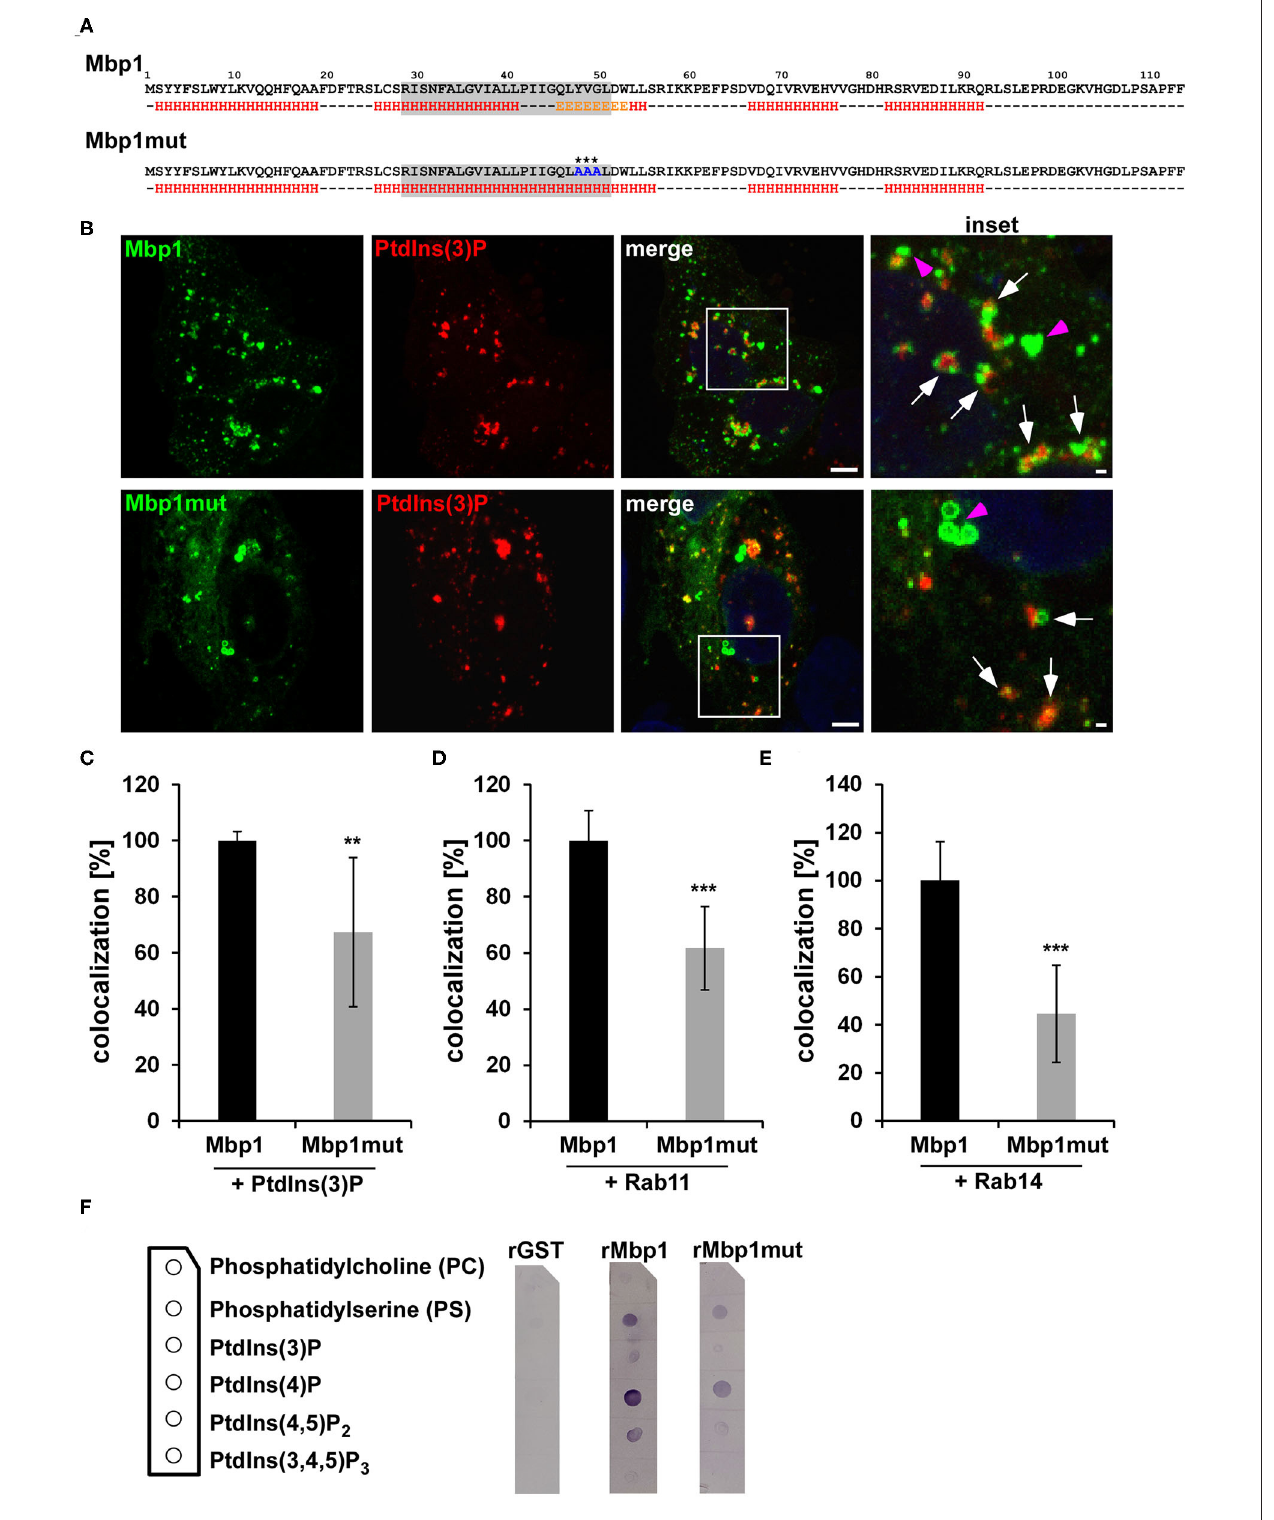
FIGURE 5 | The Mbp1 point mutant (mut) shows reduced association with PtdIns(3)P, Rab11, and Rab14-positive membranes. (A) Schematic representation of wild type (Mbp1) and mutant (Mbp1mut) amino acid sequences and their underlying predicted secondary structures using https://npsa-prabi.ibcp.fr/cgi-bin/ npsa_automat.pl?page=/NPSA/npsa_gor4.html. H = α -helix E = β -sheet. The gray box displays the transmembrane domain predicted with